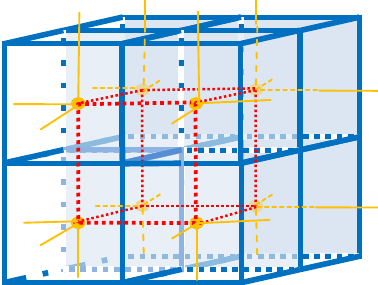
Figure 6. Primal and the dual spaces in a complex cell such as a